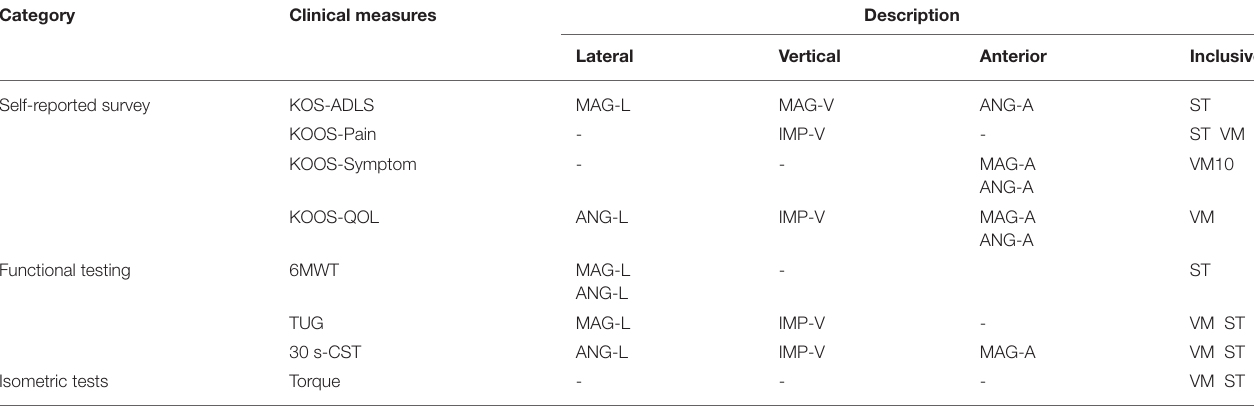
TABLE 3 | Selected inertial variables using stepwise regression to predict clinical measures.